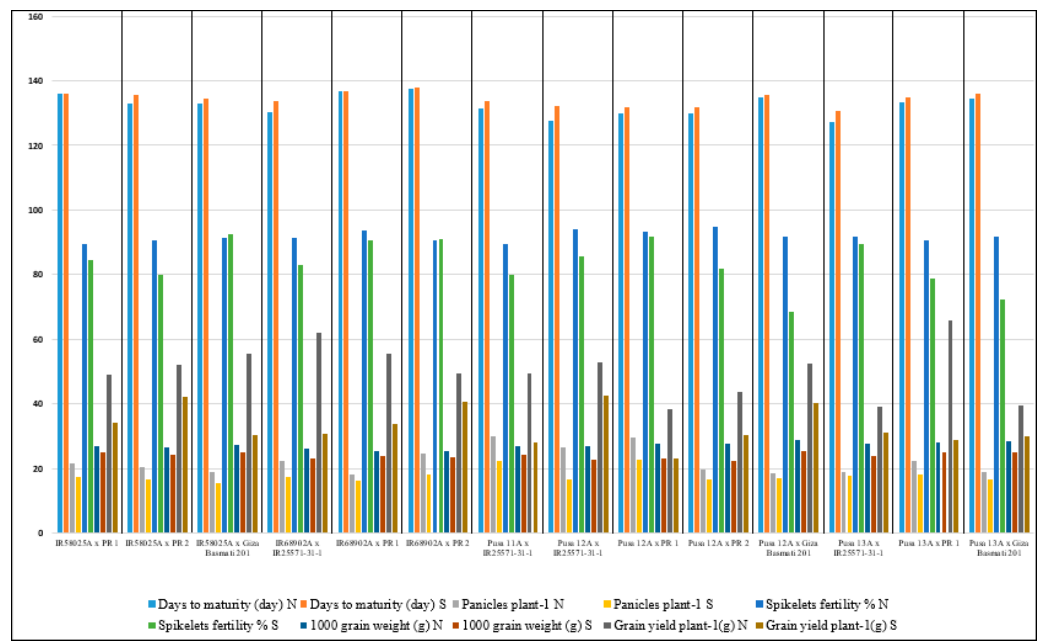
Figure 2. The mean performance of promising genotypes for five economic yield characteristics under normal and water-stress conditions. N (normal irrigation conditions), and S (water-stress conditions).